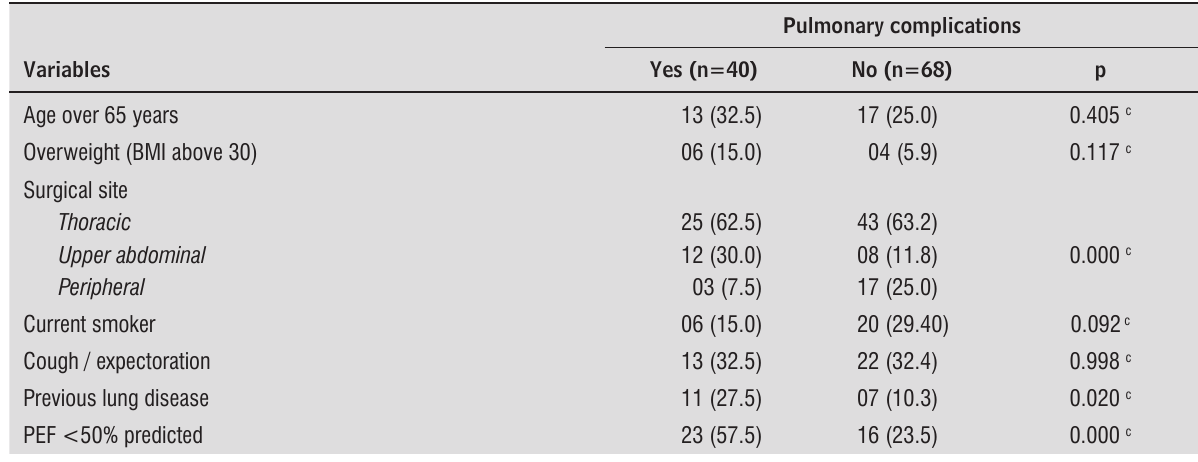
Table 5 - Distribution of PPC with respect to the items evaluated on the scale